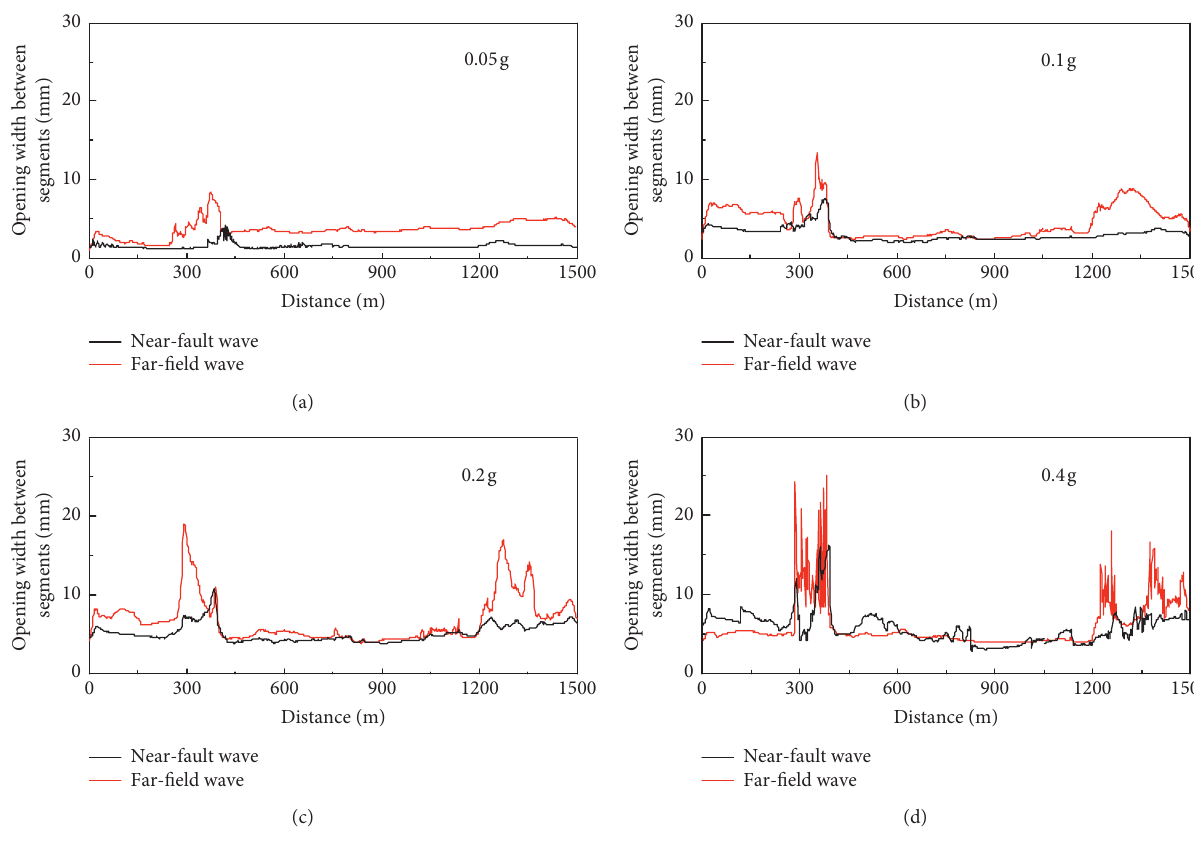
Figure 11: Intersegment opening width